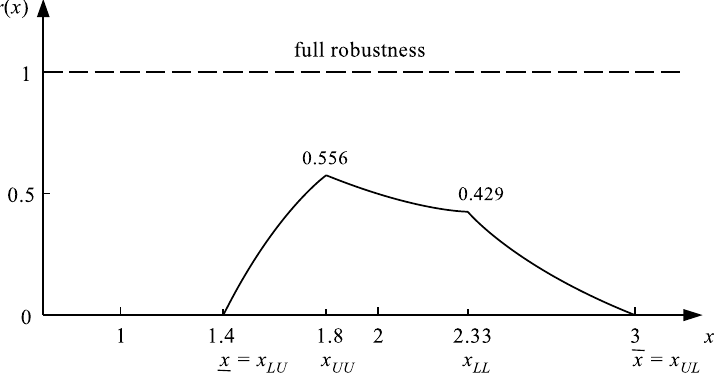
Figure 9. Distribution of the achievable robustness r ( x ) for the individual possible control values x : optimal value x opt = 1.8, r ( x = 1.8 ) =